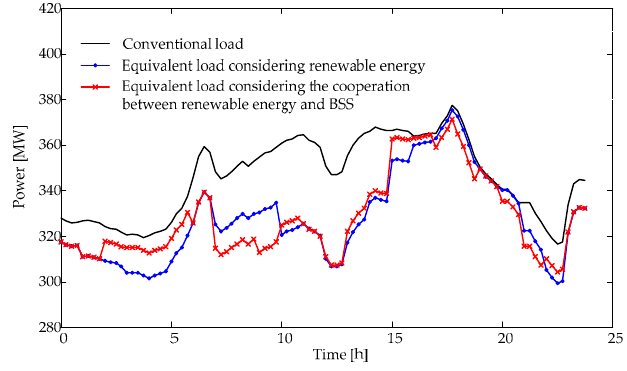
Figure 7. The load curve under different conditions.